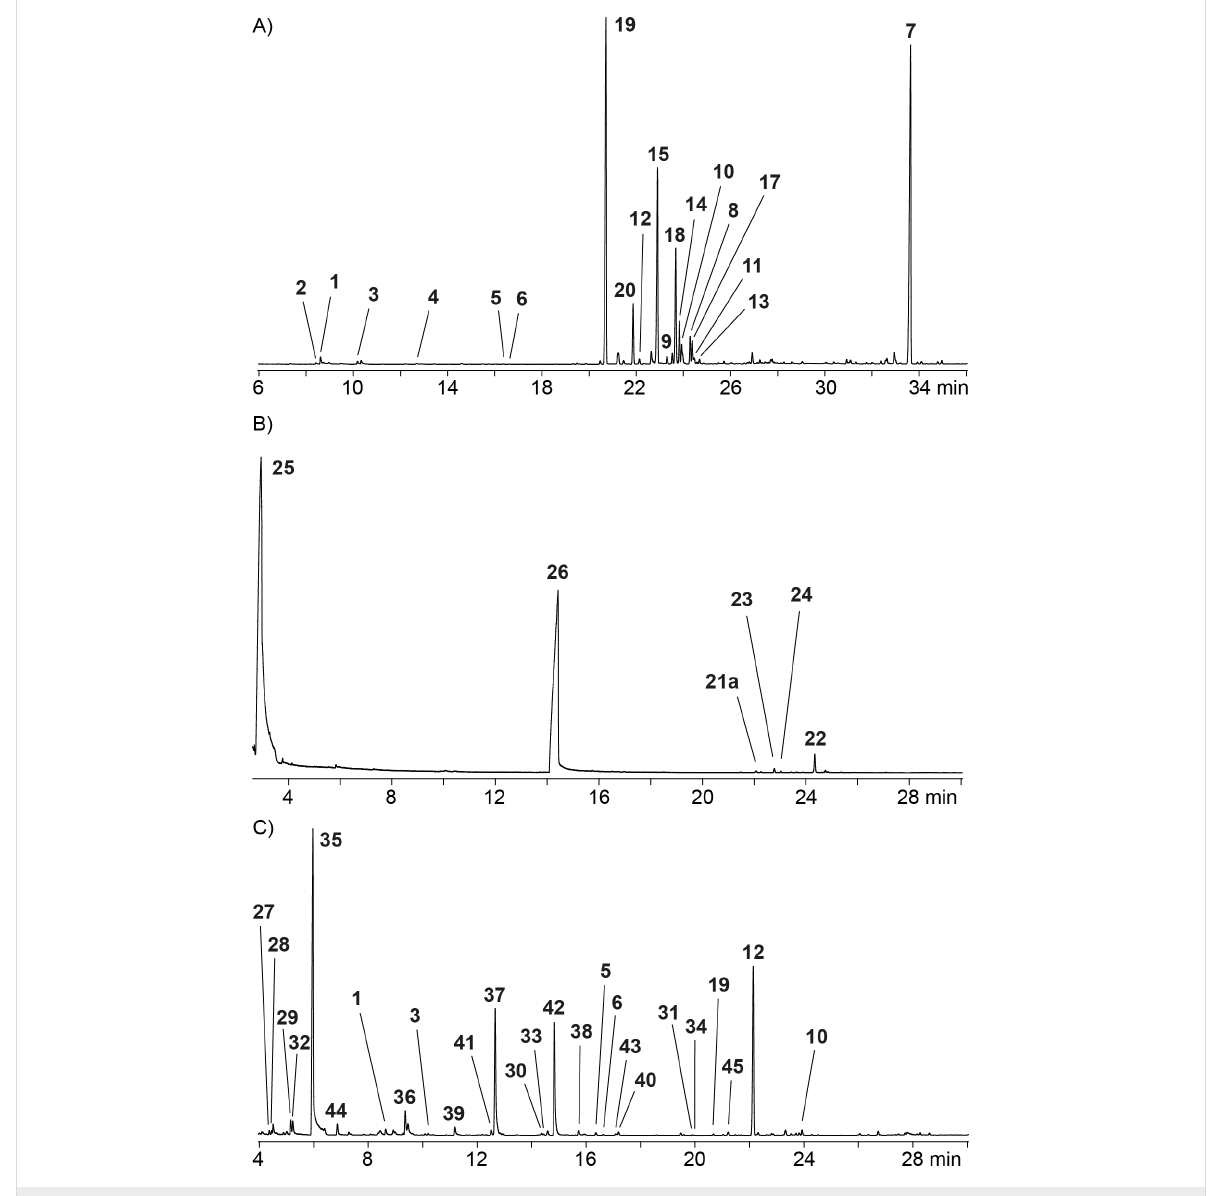
Figure 1: Total ion chromatograms of headspace extracts from A) Aspergillus fischeri NRRL 181, B) Aspergillus kawachii NBRC 4308, and C) Aspergillus clavatus NRRL 1. Numbers at peaks refer to compound numbers as defined in Table 1 and Schemes